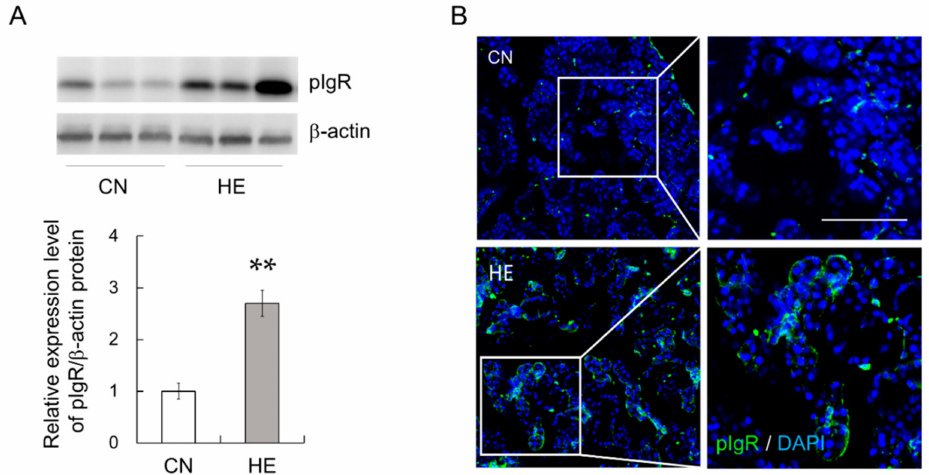
Figure 3. Polymeric immunoglobulin receptor (pIgR) expression in the submandibular glands (SMGs) of control (CN) and heat-exposed (HE) rats. ( A ) pIgR protein expression in the SMGs. Heat exposure increased pIgR protein expression in the SMGs. Left 3 lanes show CN rats, and right 3 lanes show HE rats. Values are presented as the mean ± SEM ( n = 8 in each group). ** p < 0.01, significant di ff erence between the CN and HE groups. ( B ) Immunohistochemical analysis of pIgR (green) in the SMGs. The nuclei were stained with 4 (cid:48) ,6-diamidino-2-phenylindole (DAPI, blue). The right panel shows magnified views of the boxed regions from the CN and HE groups. Scale bar, 25 µ